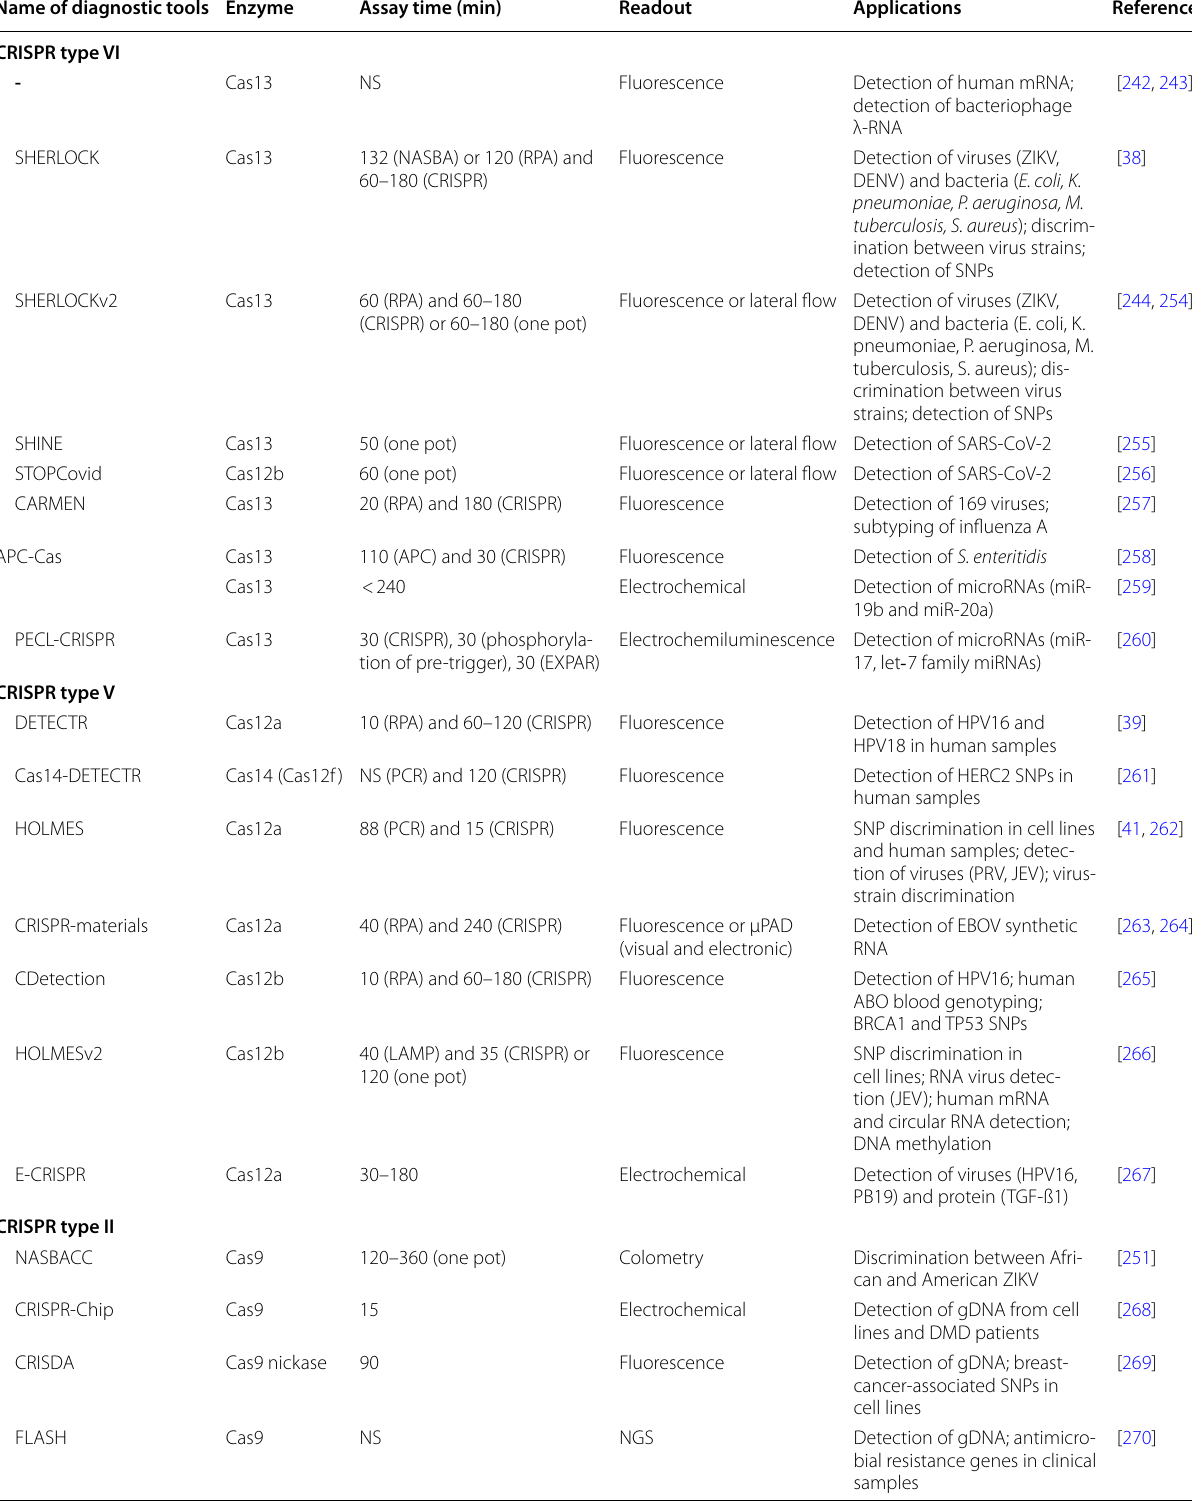
Table 4 Introduction of reported CRISPR-based diagnostics Name of diagnostic tools